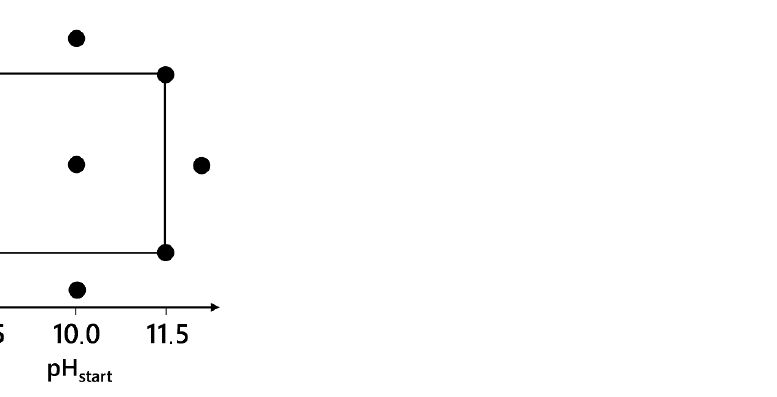
Figure 3. Design space with schematic representation of three types of experiments: four center point replications, four factorial design points and four axial points.